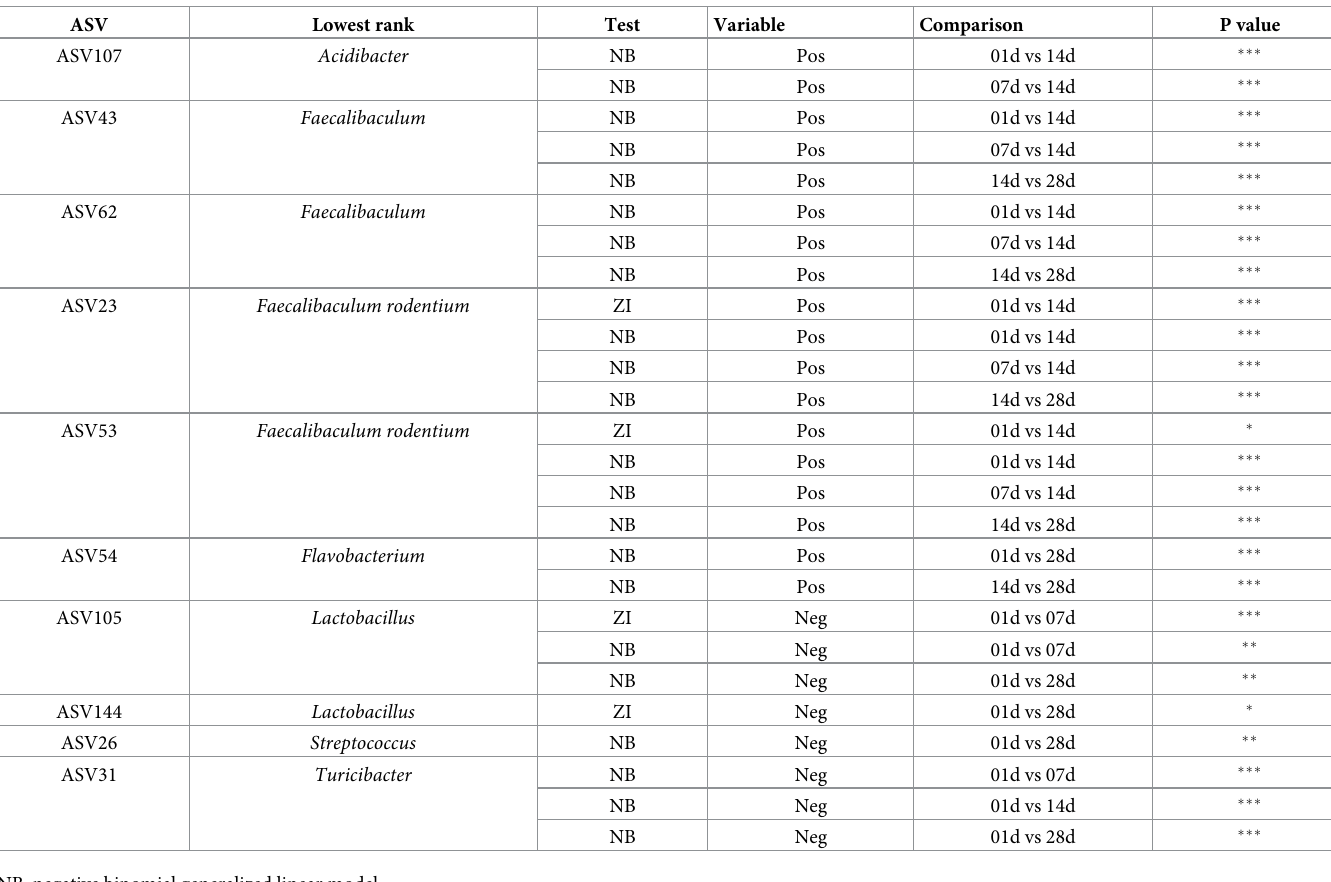
NB, negative binomial generalized linear